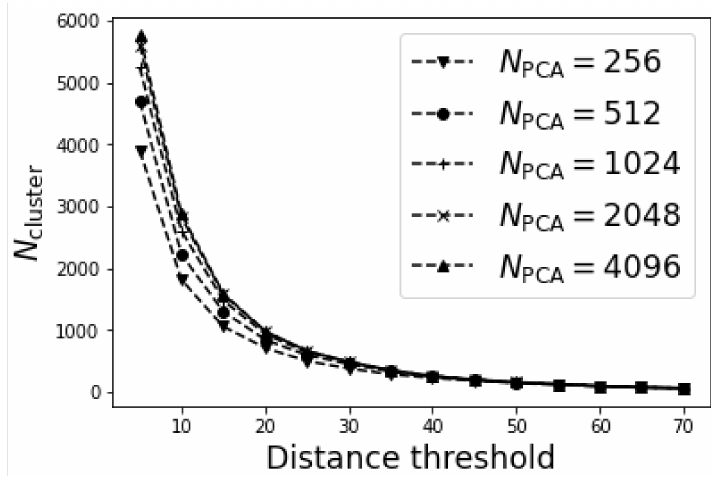
Figure 4. The variation of number of clusters N cluster with the distance